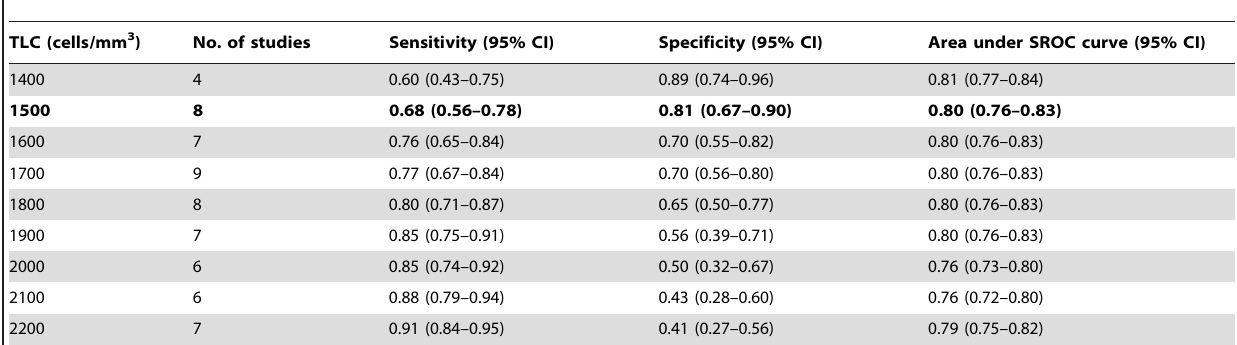
Table 3. Pooled effects for predicting a CD4 cell count , 350 cells/mm 3 by using different TLC thresholds.